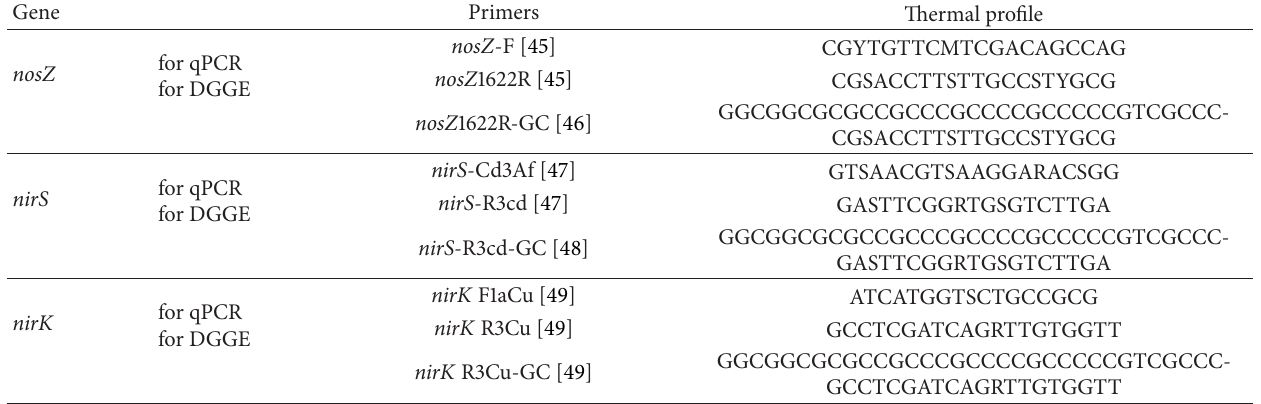
Table 1: Primers used for the qPCR and